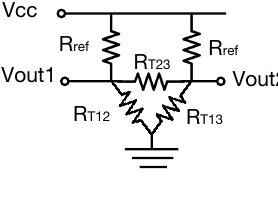
Figure 4. Sensor output circuit.